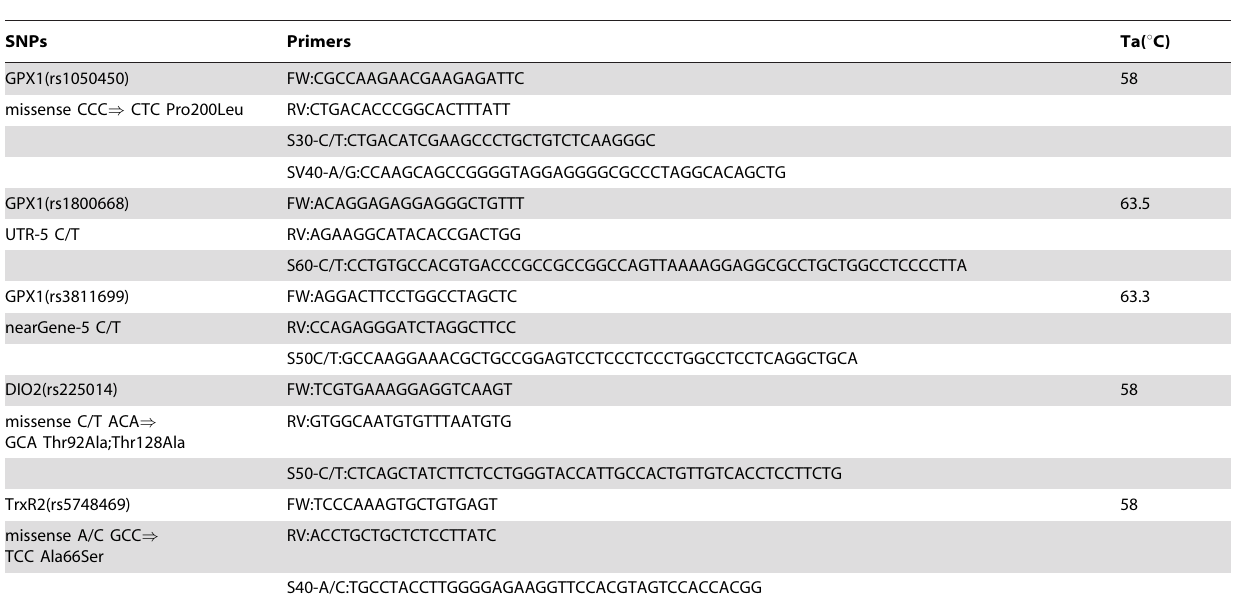
Table 2. Conditions used for genotyping